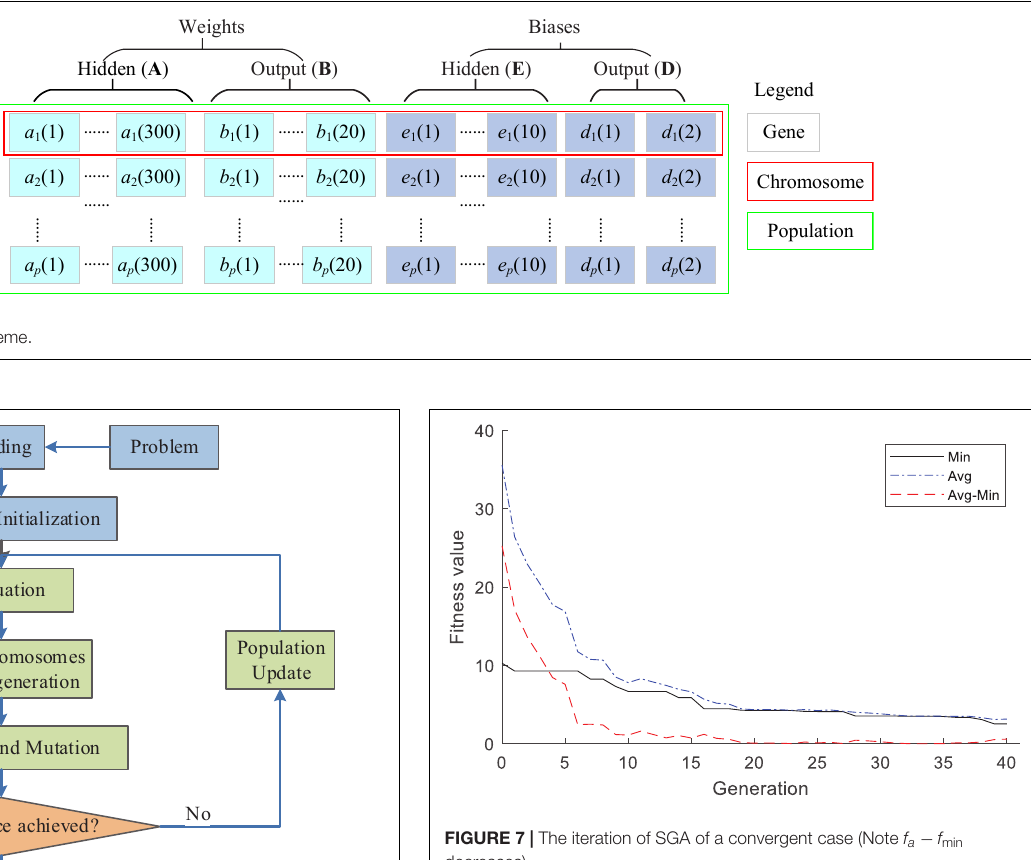
where 0 = k c , k m =